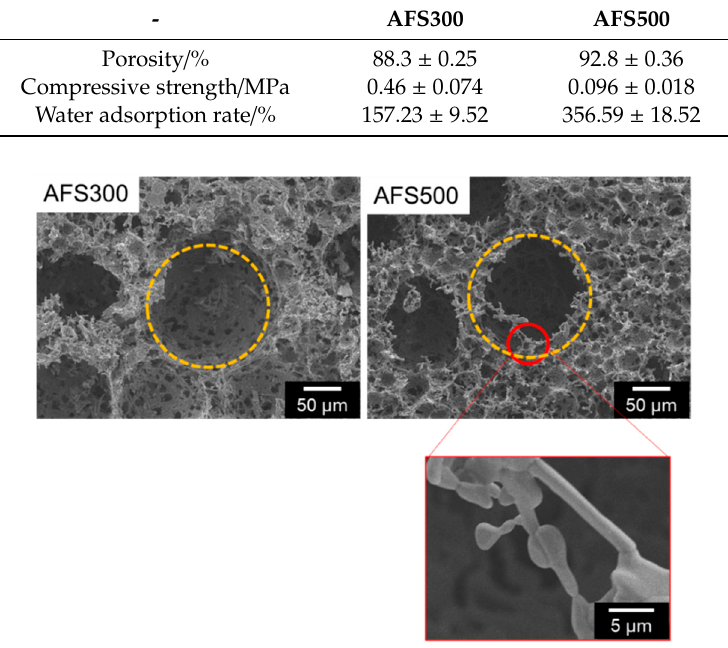
Figure 5. SEM images of AFS300 and AFS500 with two types of pores. Yellow circles indicate macro pores and red one represents micro pores. Scale bars represent 5, 50 μ m, respectively. Table 1. The material properties of apatite-fiber scaffolds (AFSs) .